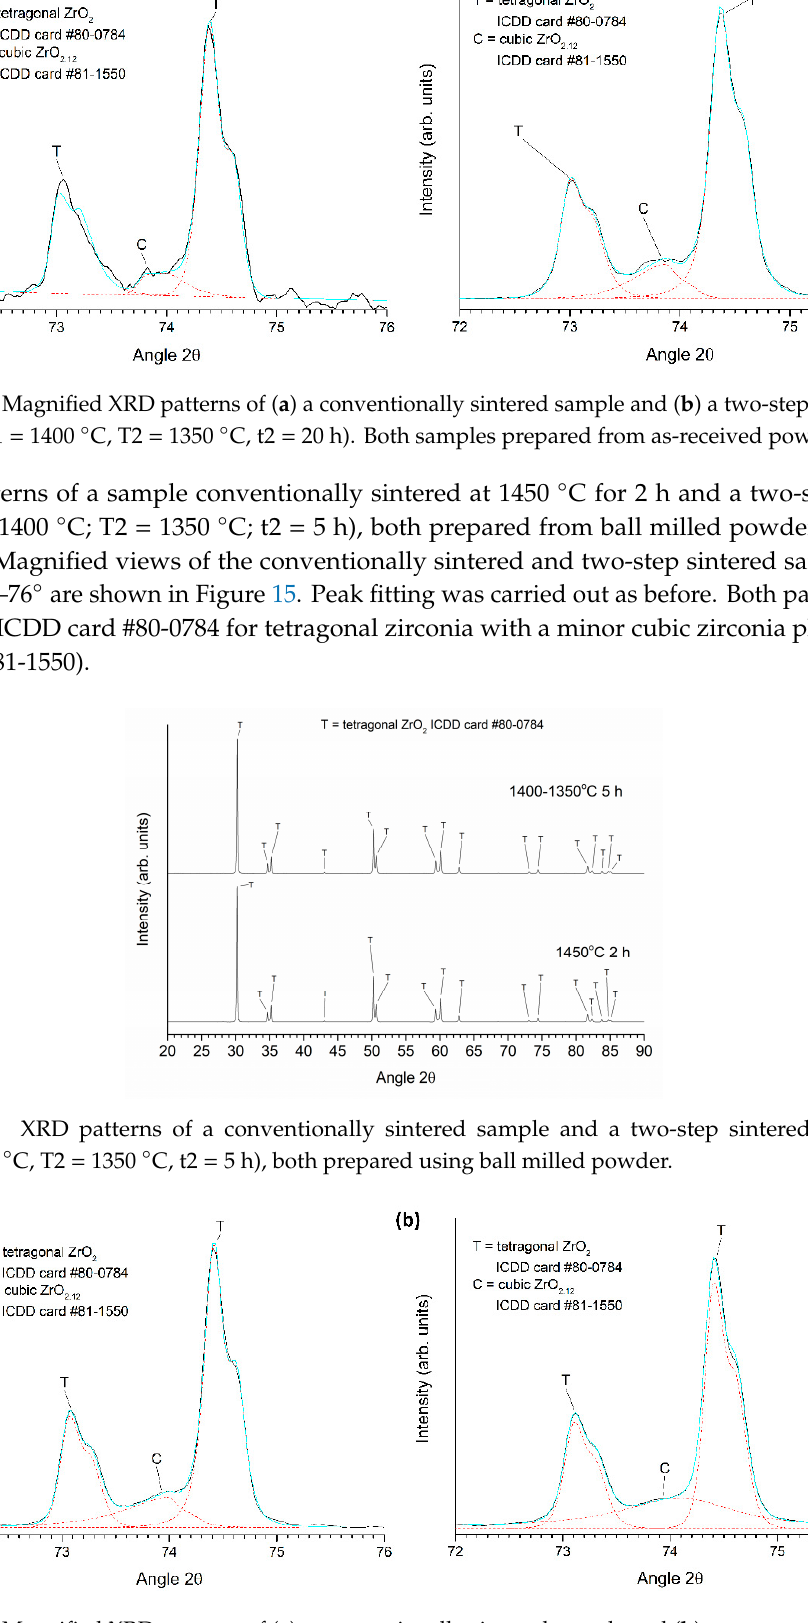
Figure 15. Magnified XRD patterns of ( a ) a conventionally sintered sample and ( b ) a two-step sintered sample (T1 = 1400 °C, T2 = 1350 °C, t2 = 5 h). Both samples were prepared using ball milled powder.